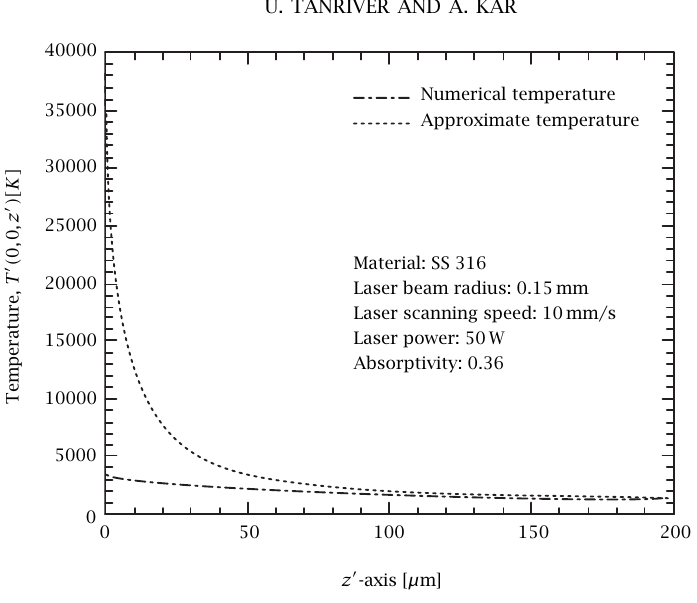
Figure 2.1 . Comparison between the numerical and approximate tempe- ratures ( r = 0 case).